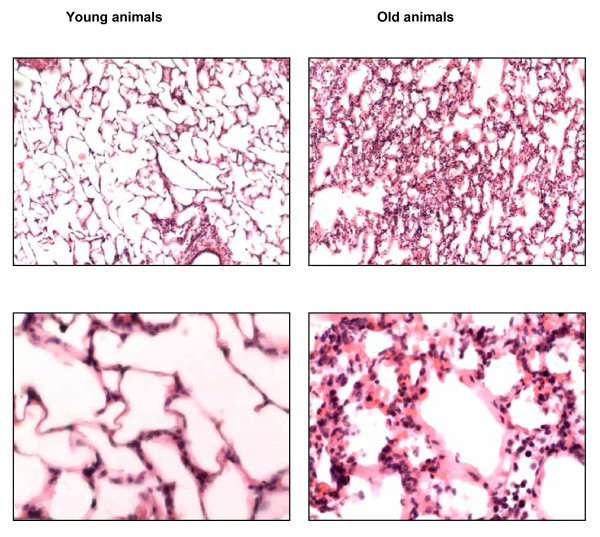
Representative lung histology in young and old rats follwing mechanical ventilation with high tidal volume. Tidal volume was 24 ml/kg for 4 h. Tissue sections are stained with hematoxylin and eosin. Magnification is 100x (upper panel) and 400x (lower panel).